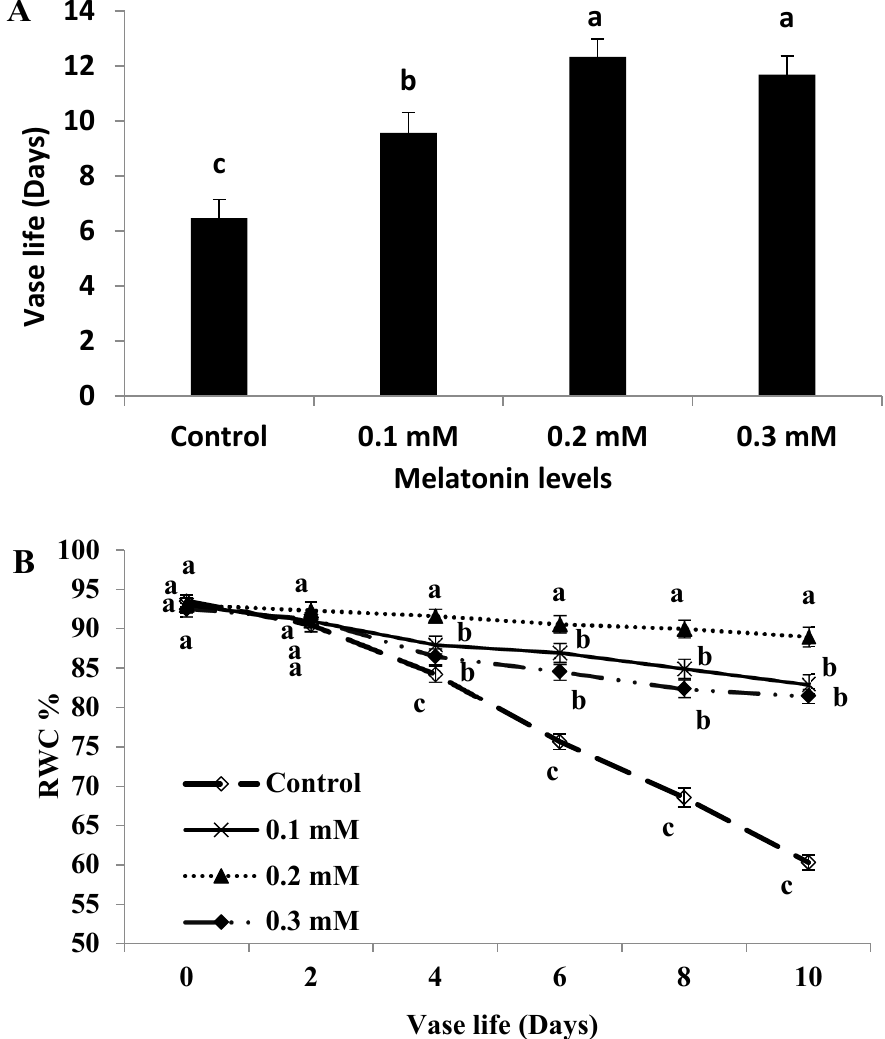
Figure 1. Vase life ( A ) and relative water content ( B ) of cut roses treated with melatonin at 0.1, 0.2 and 0.3 mM. Each value is the mean ± SE of two experiments. Values that have different letters are significantly different based on Tukey-Kramer’s multiple range test at p ≤ 0.05.